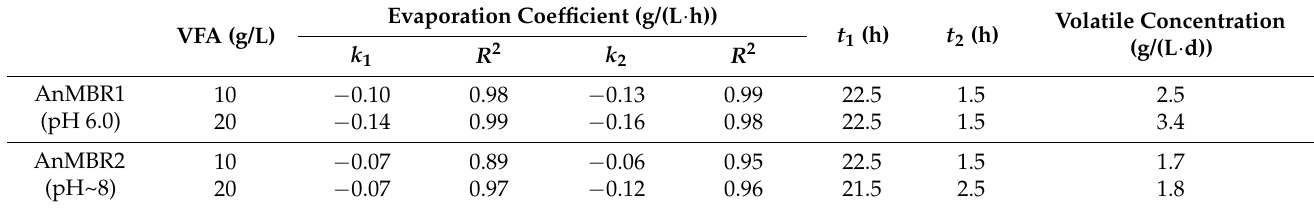
(Table 2). VFA evaporation correction has been considered in all VFA results presented. Table 2. Results of Volatile fatty acids (VFA) evaporation test under different conditions of pH, N 2 sparging rates and initial VFA